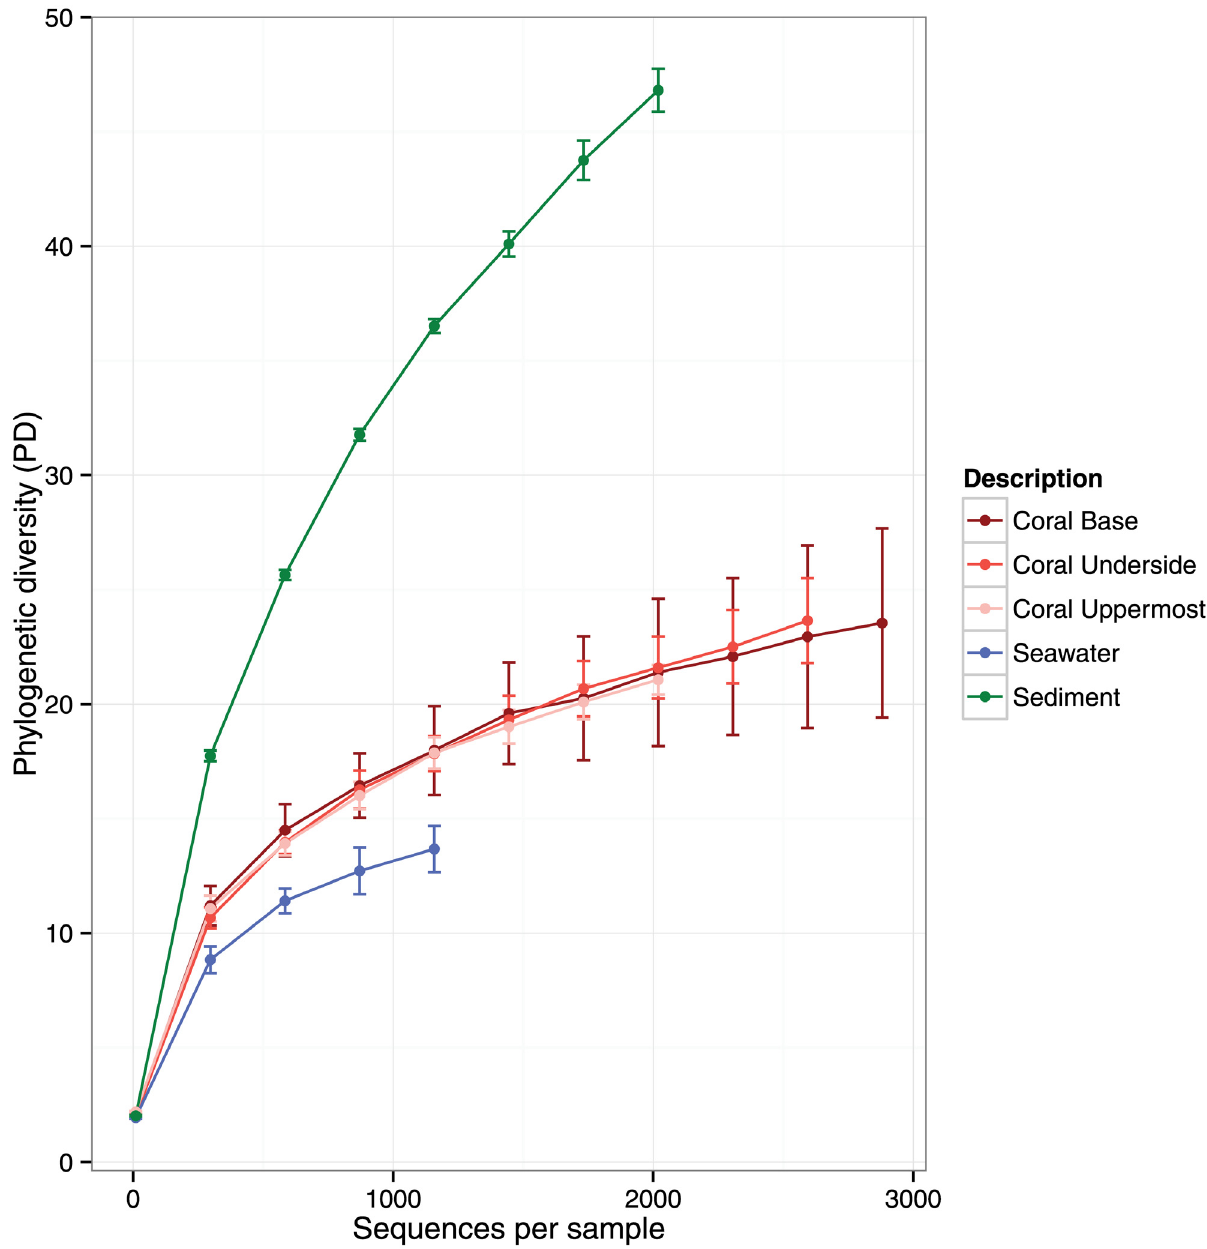
Fig 2. Measurements of biodiversity within each coral region, surrounding reef seawater, and sediment sampled. Rarefaction curves for microbial communities calculated for 3 coral surface types (n = 3 – 4; 11 samples), reef seawater (n = 4), and sediment samples (n = 2). Operational taxonomic unit (OTU 0.03 ) richness rarefaction curves were estimated by phylogenetic diversity